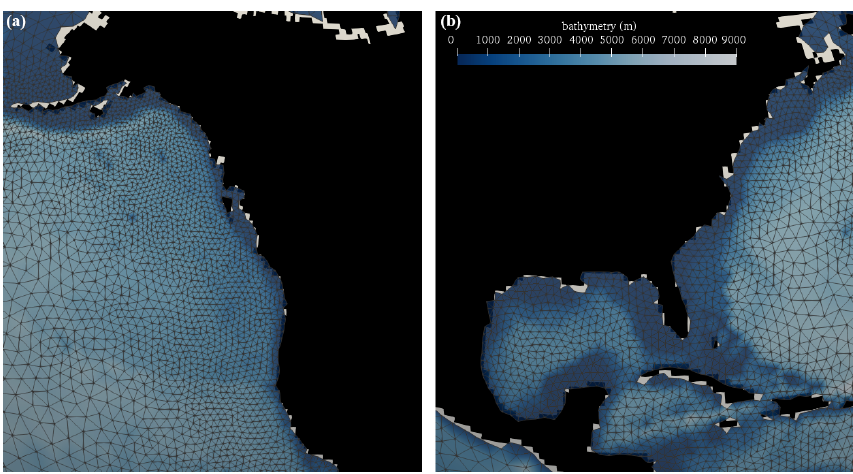
Figure 14. Differences in coastline representation between the 0.5 ◦ structured and unstructured meshes for the US west coast (a) and US east coast/Gulf of Mexico (b) . The structured mesh coastline is represented in black. The white regions and overlap between the black coastline and the triangular elements indicate mismatches in the mesh boundaries.